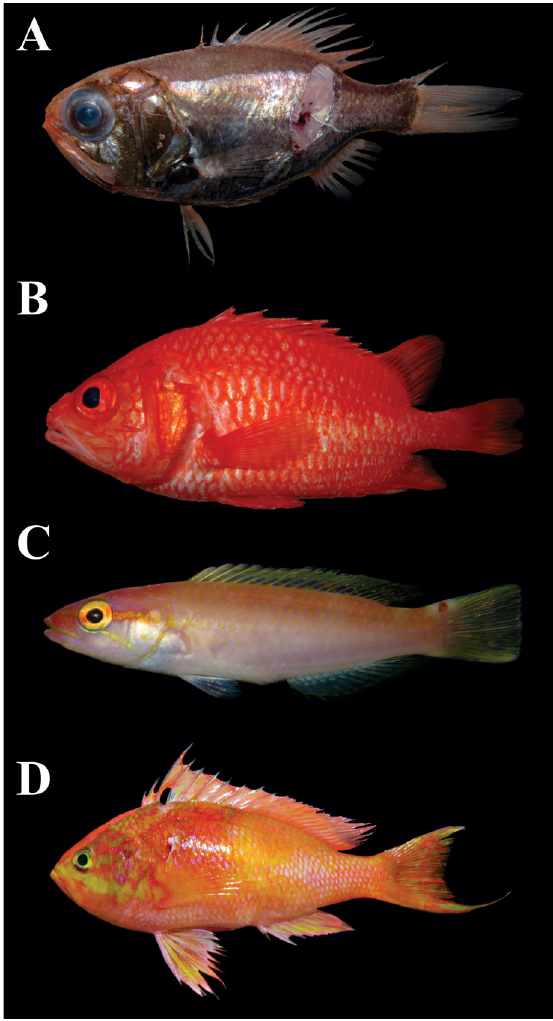
FIGURE 5 | New records of fishes from the mesophotic ecosystems collected and photographed in aquarium. A. Aulotrachichthys argyrophanus (~ 6.5 cm total length; CIUFES 3909); B. Corniger spinosus (~ 15 cm total length; CIUFES